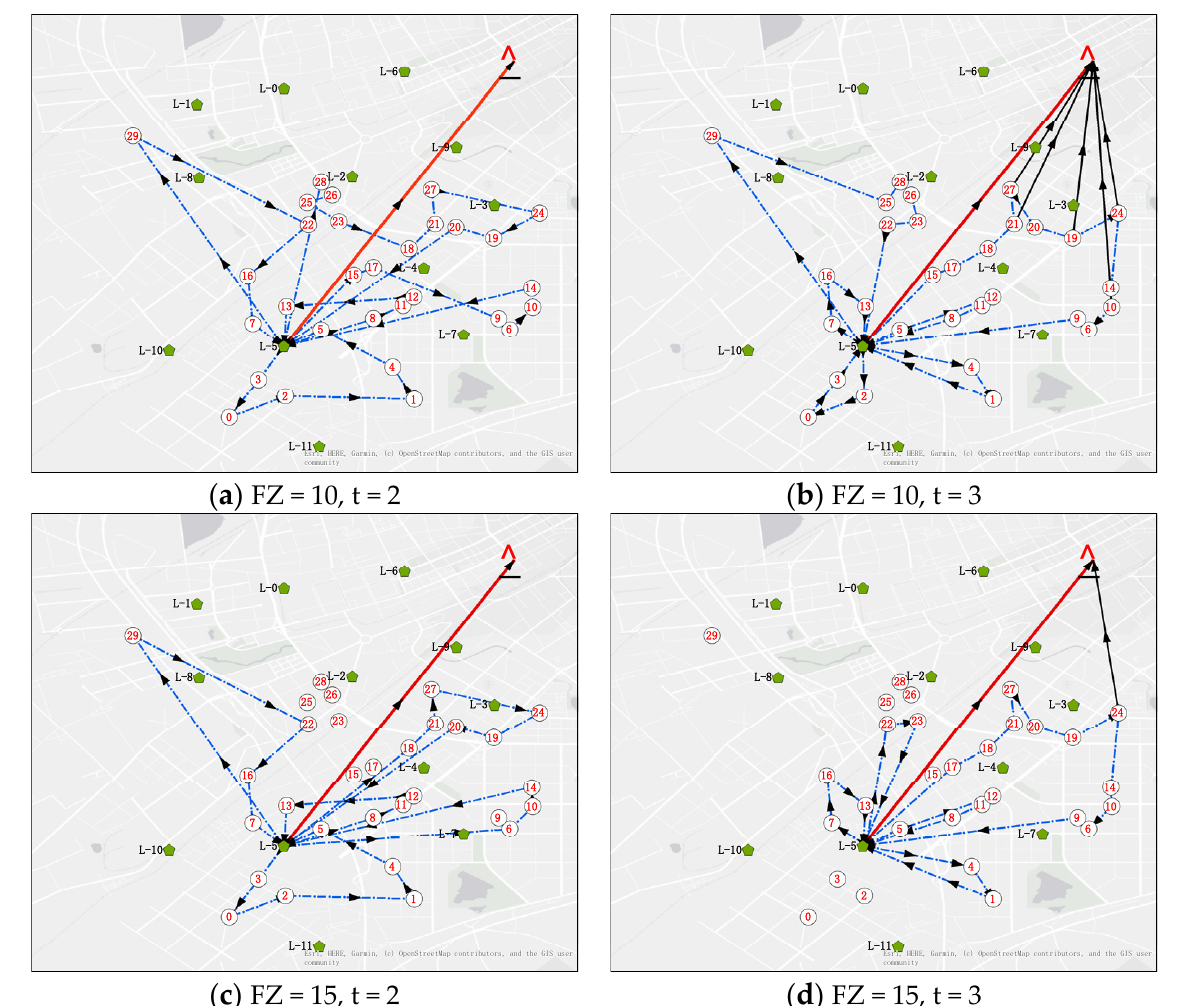
Figure 7. The impact of FZ on the routing decisions. The above parameters influence the system performance by affecting the location of DCs, inventory capacity, and delivery routing decisions. Overall, we can conclude that the total system cost and carbon emission are sensitive to the above four parameters.